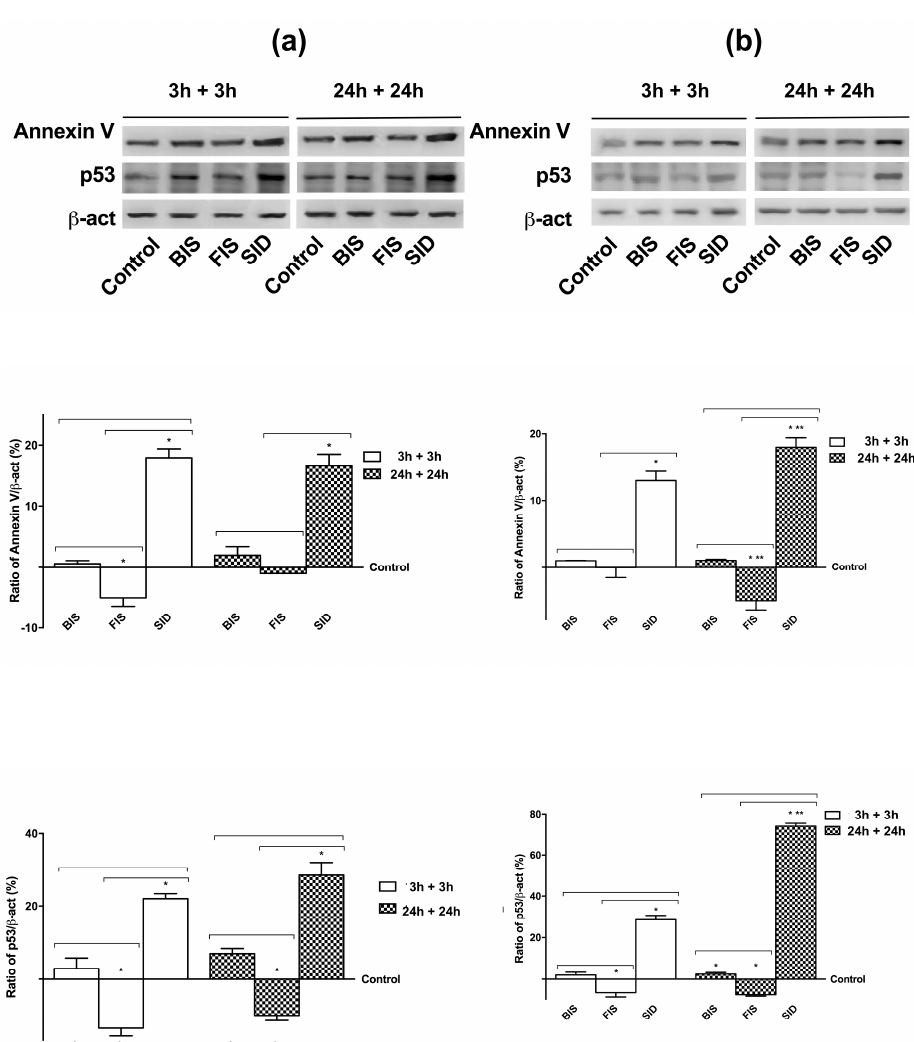
Figure 7. Western blot and densitometric analysis of p53 and Annexin V on GTL-16 ( a ) and Caco-2 cells ( b ) maintained for equal time (3 h plus 3 h; 24 h plus 24 h) without iron treatments. Western blot (upper) and densitometric analysis (down) are reported. The results after normalization through β -act and control, are expressed as a means ± SD (% vs. control) of four independent experiments for each cell type. * p < 0.05 vs. control; ** p < 0.05 vs. correspondent column at different time; bars p < 0.05 among different treatments at the same time.